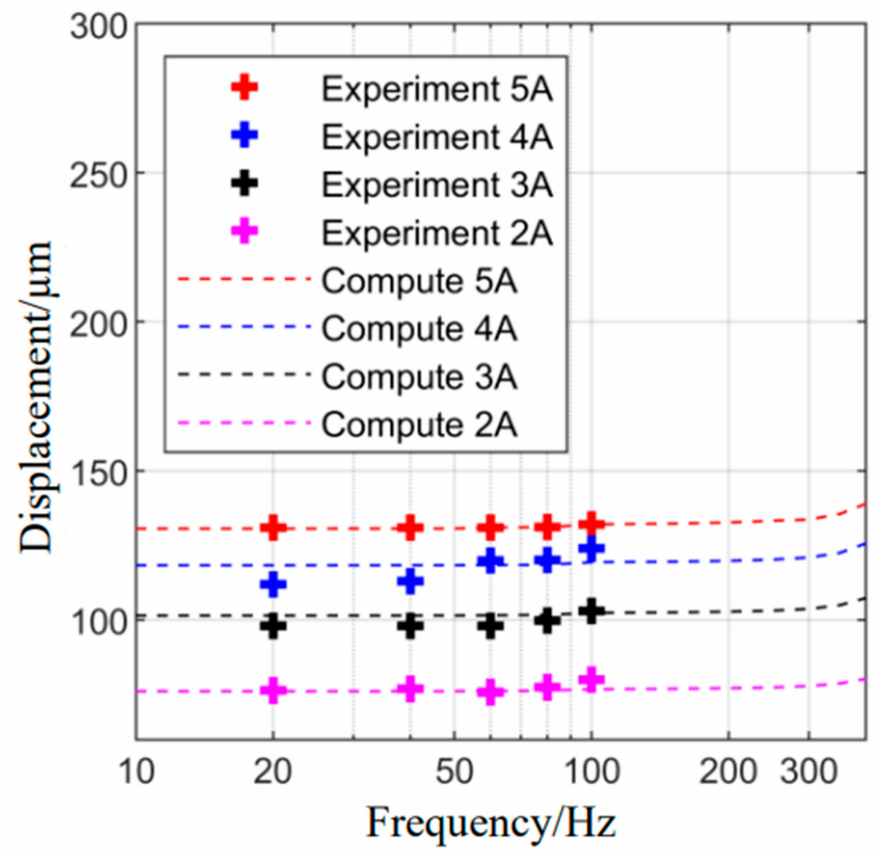
Figure 10. GMA amplitude-frequency characteristic.